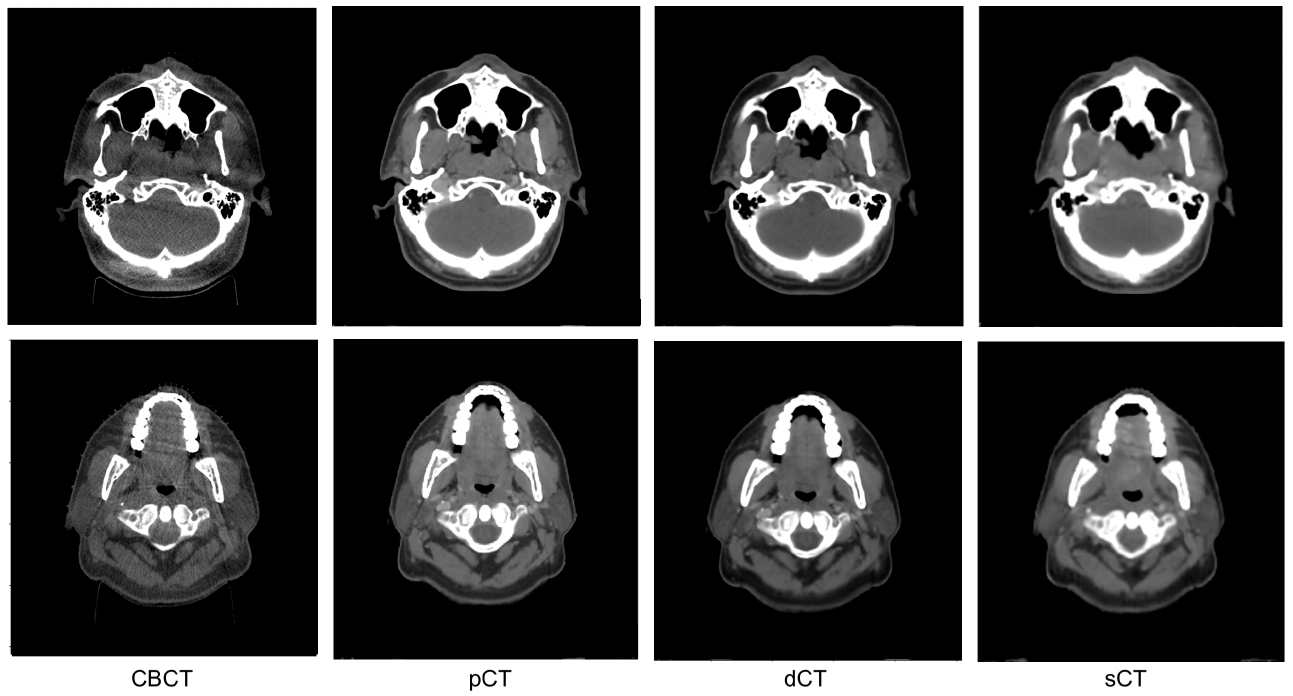
Figure 7. Qualitative comparison of CBCT, dCT, pCT and sCT from two different axial slices in the test set. sCT was generated from the best performing model (UNIT with